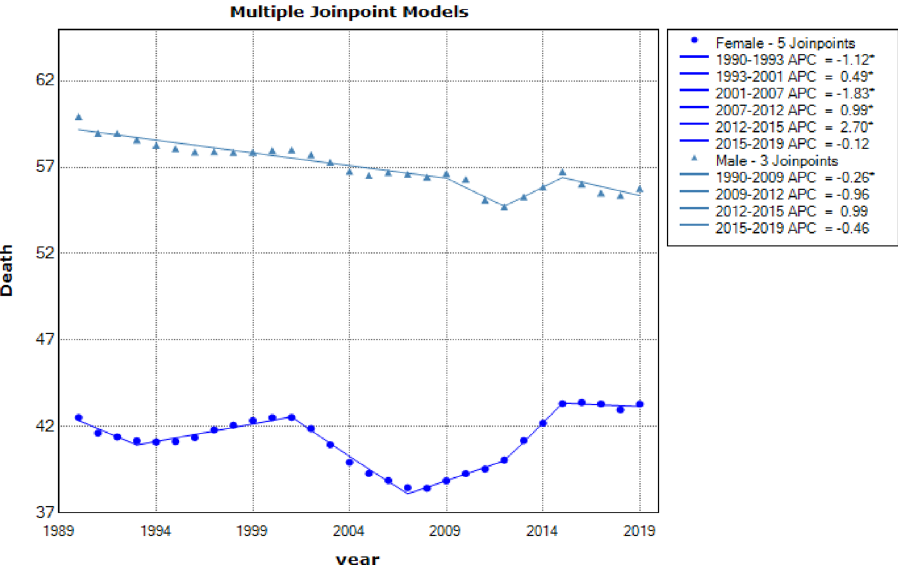
Figure 6. Joinpoint regression model for death due to particulate matter exposure in aged +50 by gender: 1990–2019.